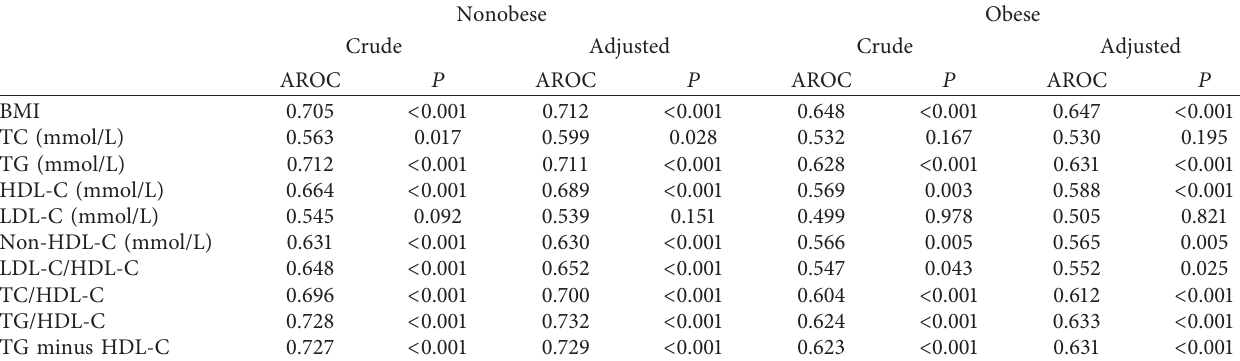
Table 4: Area under receiver operating characteristic curves for potential markers of insulin resistance before and after being adjusted for sex and